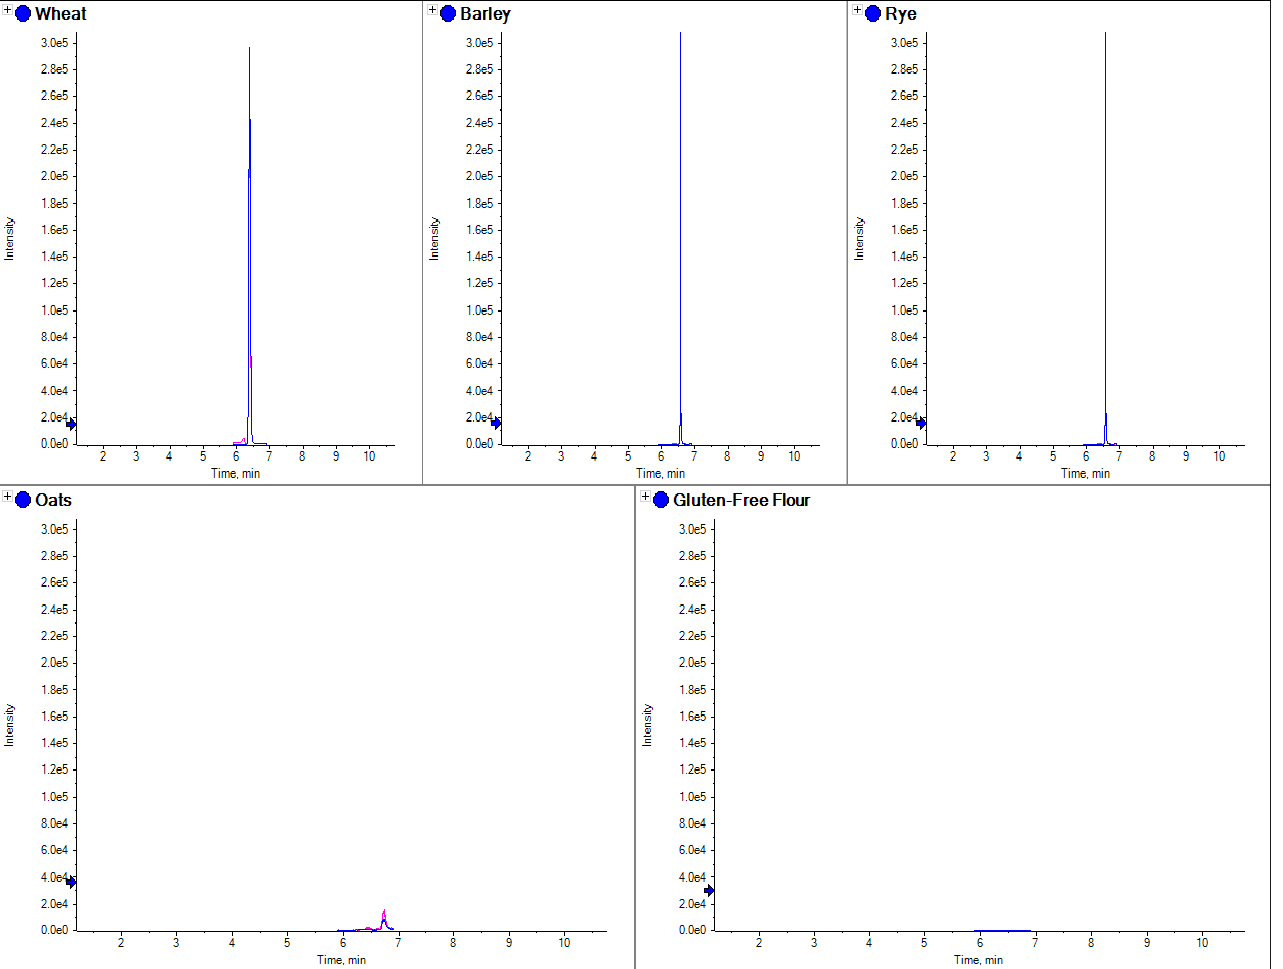
Figure 2. The comparison of separate extracts from barley, wheat, rye, oats and gluten free flour. Here the chromatograms for three MRM transitions for a specific marker peptide from beta amylase (wheat 5 in Table 3) have been shown for each